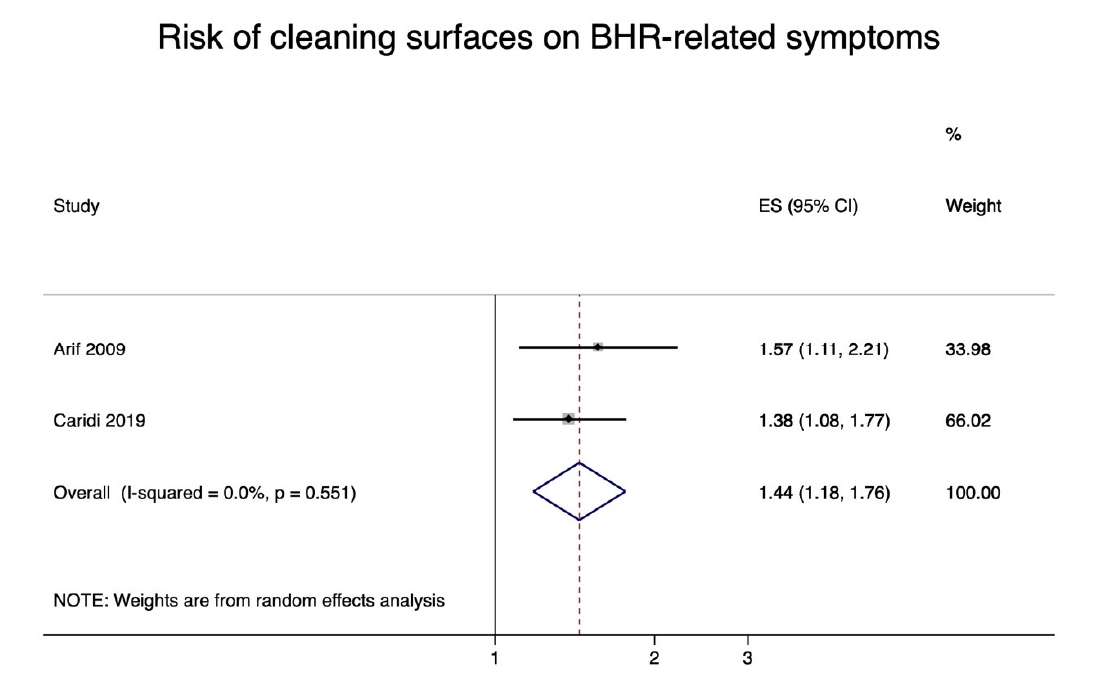
Figure 7. Pooled risk of cleaning surfaces on bronchial hyperresponsiveness (BHR)-related symptoms in nurses.